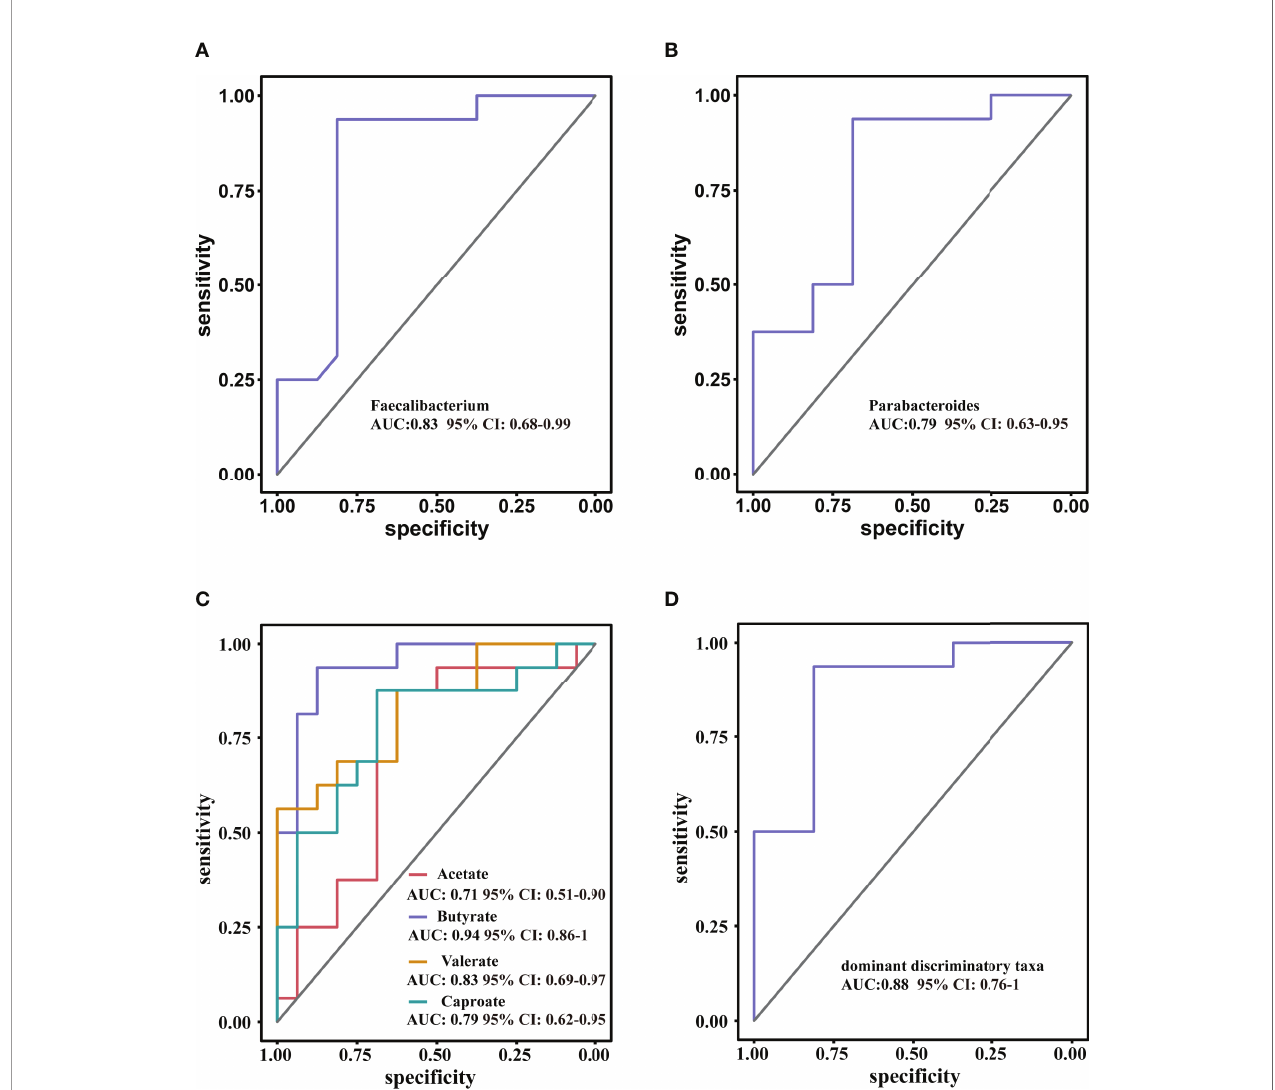
FIGURE 6 | Receiver operating characteristic curve (ROC) analysis for diagnostic indicators (A, B) the predominant bacterial taxa that may be used to distinguish ISS from CON. (C) ROC curve of the model using four discriminatory metabolites; butyrate has high diagnostic value in discriminating ISS patients from CON. (D) ROC curve of the model using two discriminatory